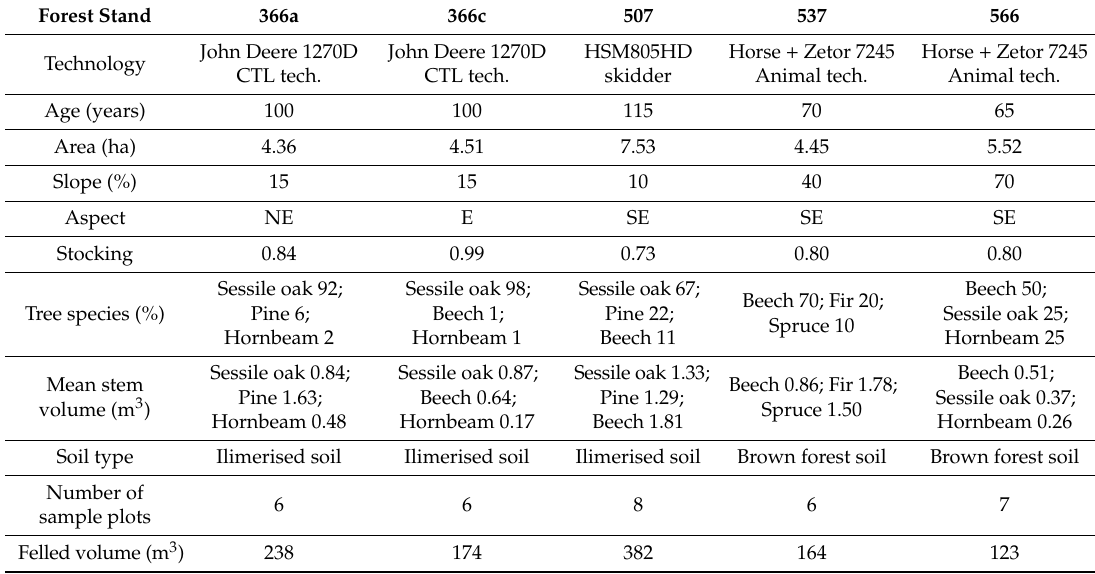
Table 1. Overview of basic stand characteristics before felling.